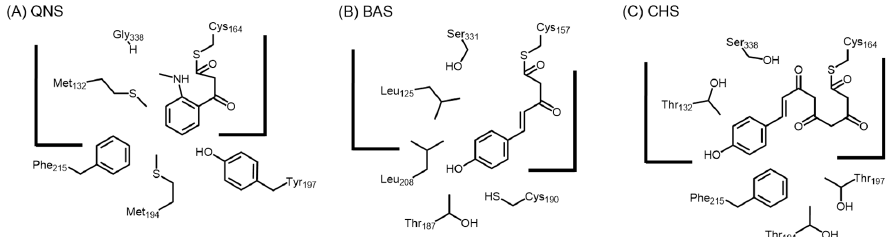
Figure 9. Comparison of the active sites ( A ) C. microcarpa QNS; ( B ) R. palmatum BAS; and ( C ) M.